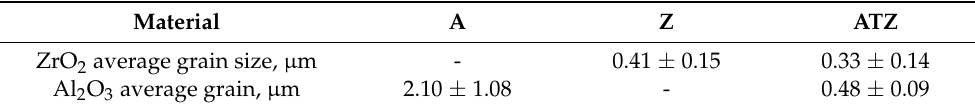
Table 1. Values of the mean grain sizes of the sintered